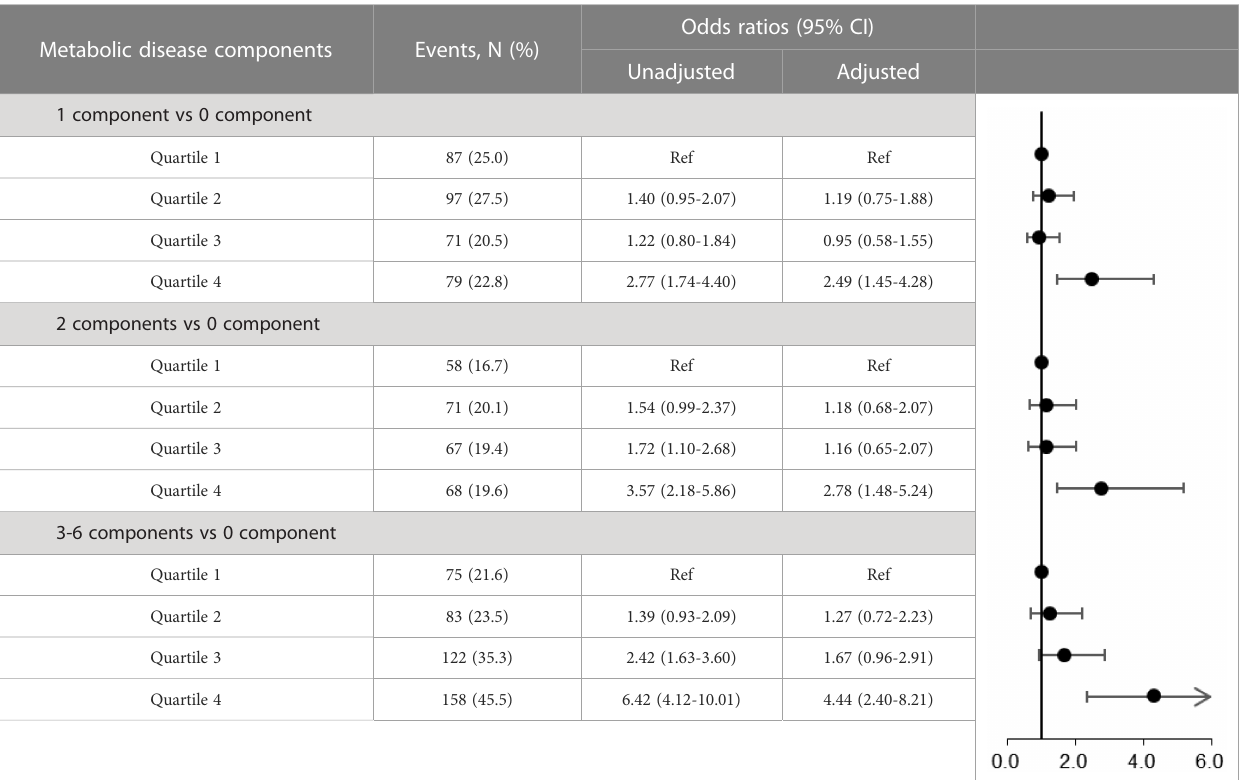
TABLE 3 Association of NAD + levels with metabolic disease components in the multivariable analysis among the whole population. Metabolic disease components Events, N (%)